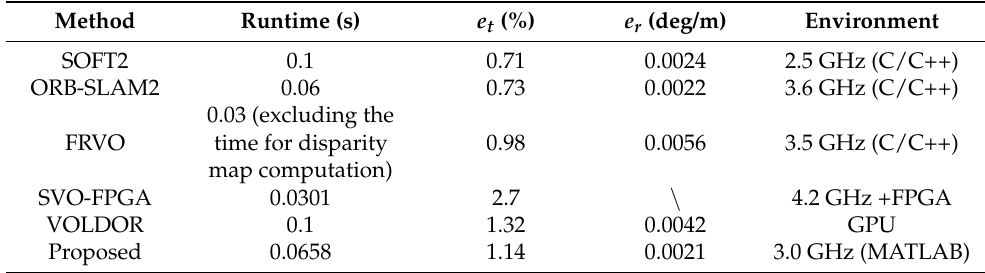
Table 4. Comparison of state-of-the-art methods on the KITTI